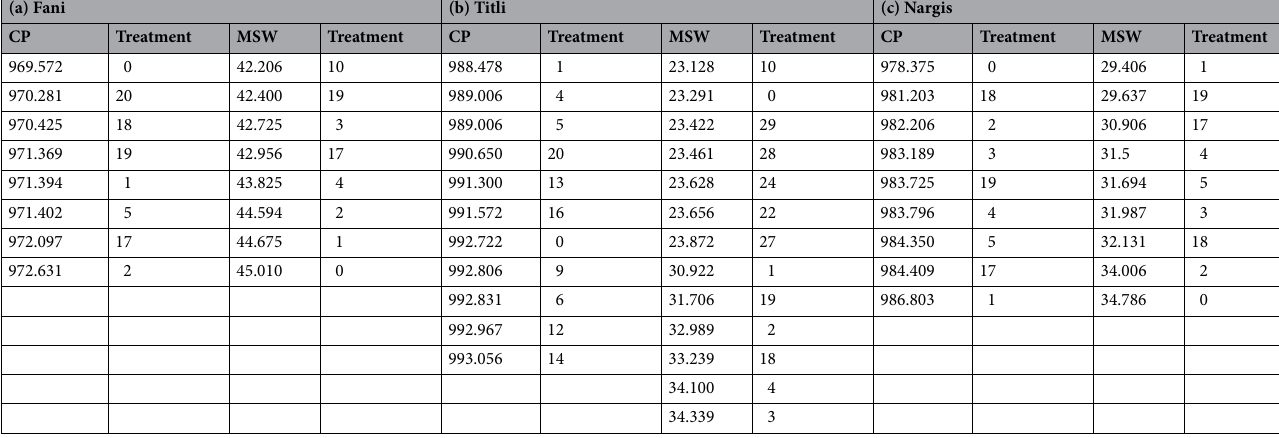
Table 14. Tukey post-hoc analysis for CP and MSW for cyclone (a) Fani (b) Titli and (c)